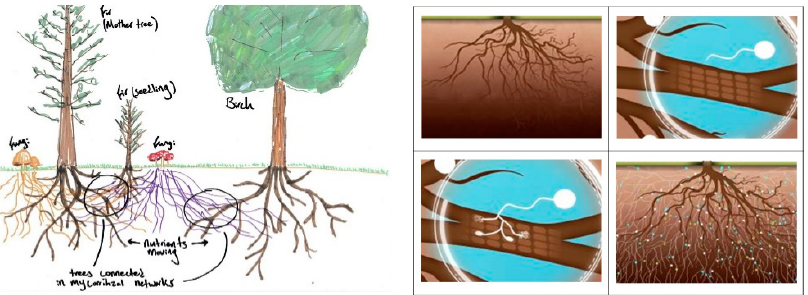
Figure 2. Other plants integrated in the MN, and Symbiosis between plant roots and fungi.